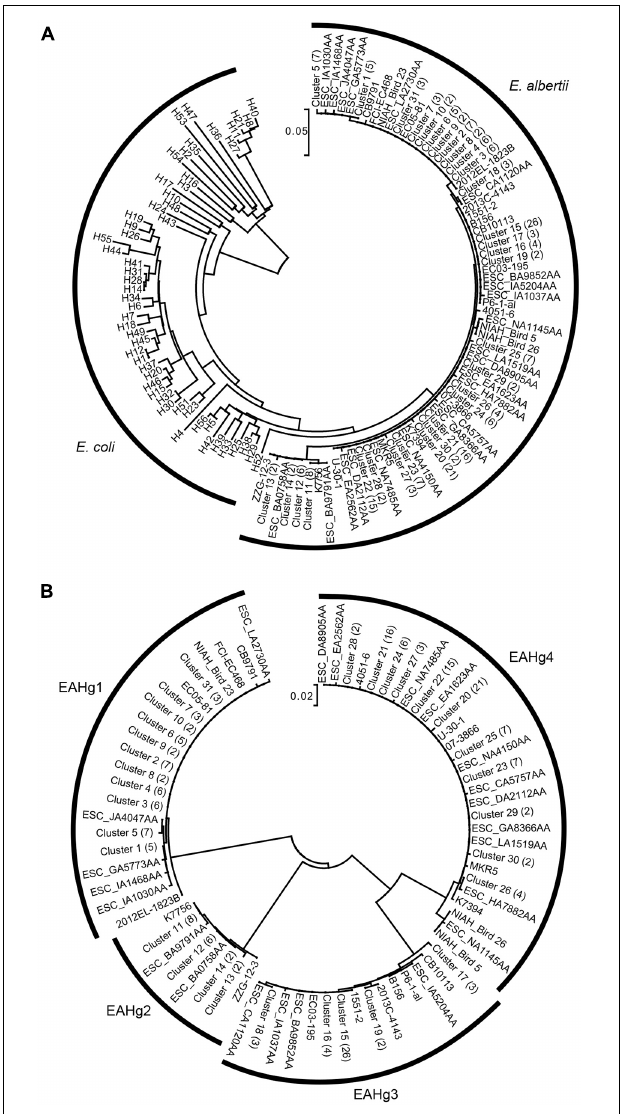
FIGURE 1 | (A) Neighbor-joining tree of 73 fliC sequences identified from 231 E. albertii strains. The sequences of 53 known fliC genotypes of E. coli are included as references. The number of strains with identical fliC sequences is shown in parentheses for each cluster. (B) Neighbor-joining tree of only the 73 fliC sequences of E. albertii . The number of strains with identical fliC sequences is shown in parentheses for each